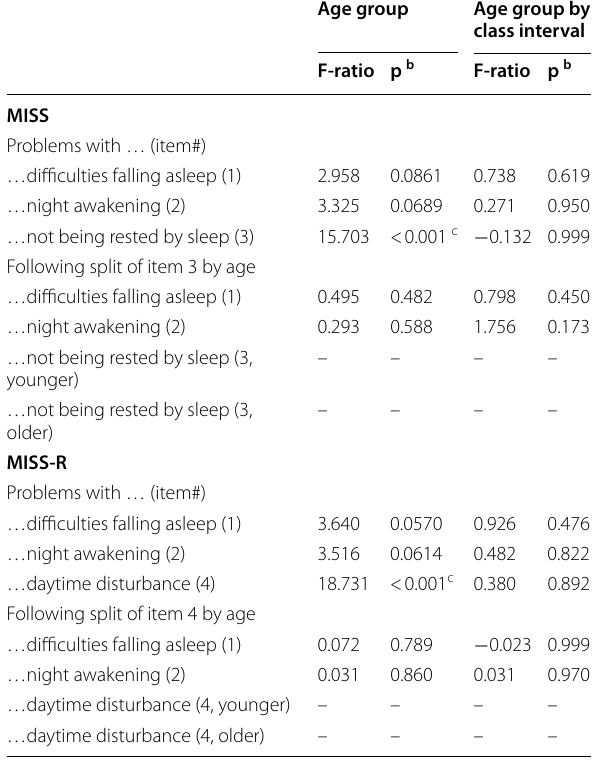
Table 4 Differential item functioning by age a of the MISS and